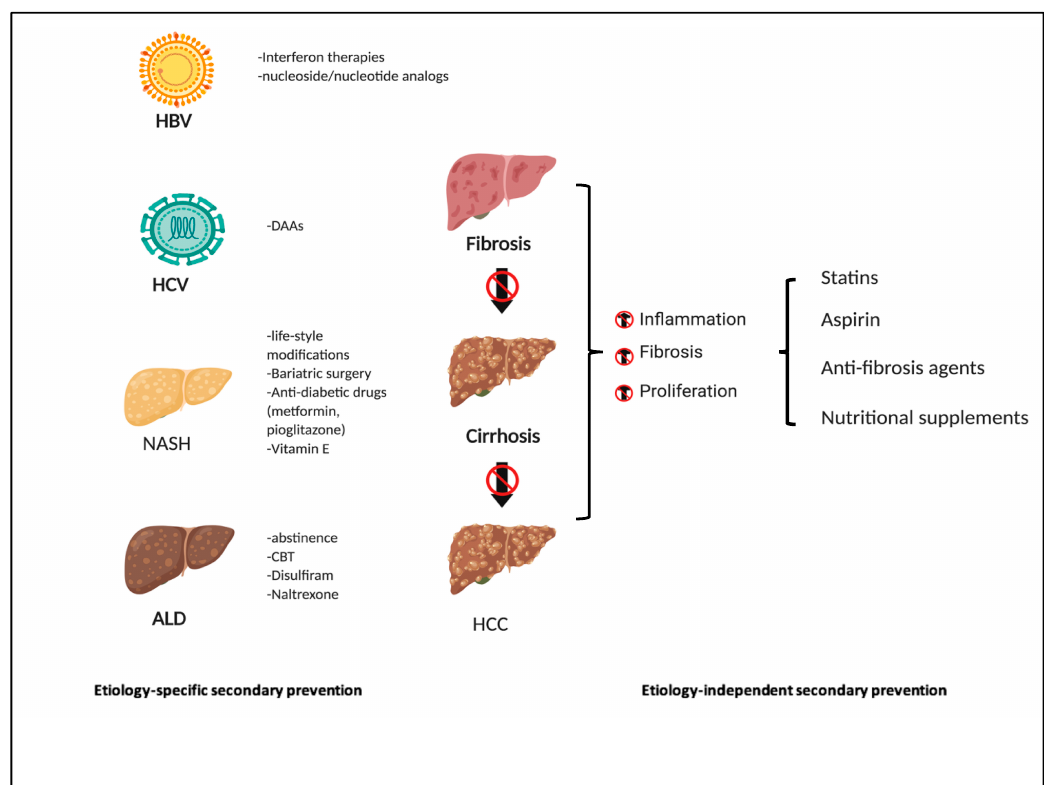
Figure 5. Etiology-specific and independent secondary HCC prevention. Etiology-specific secondary prevention targets the various risk factors of HCC development, including HBV, HCV, NAFLD/NASH, and ALD. Etiology independent prevention strategies include agents that have anti-fibrosis or anti-inflammatory activities.